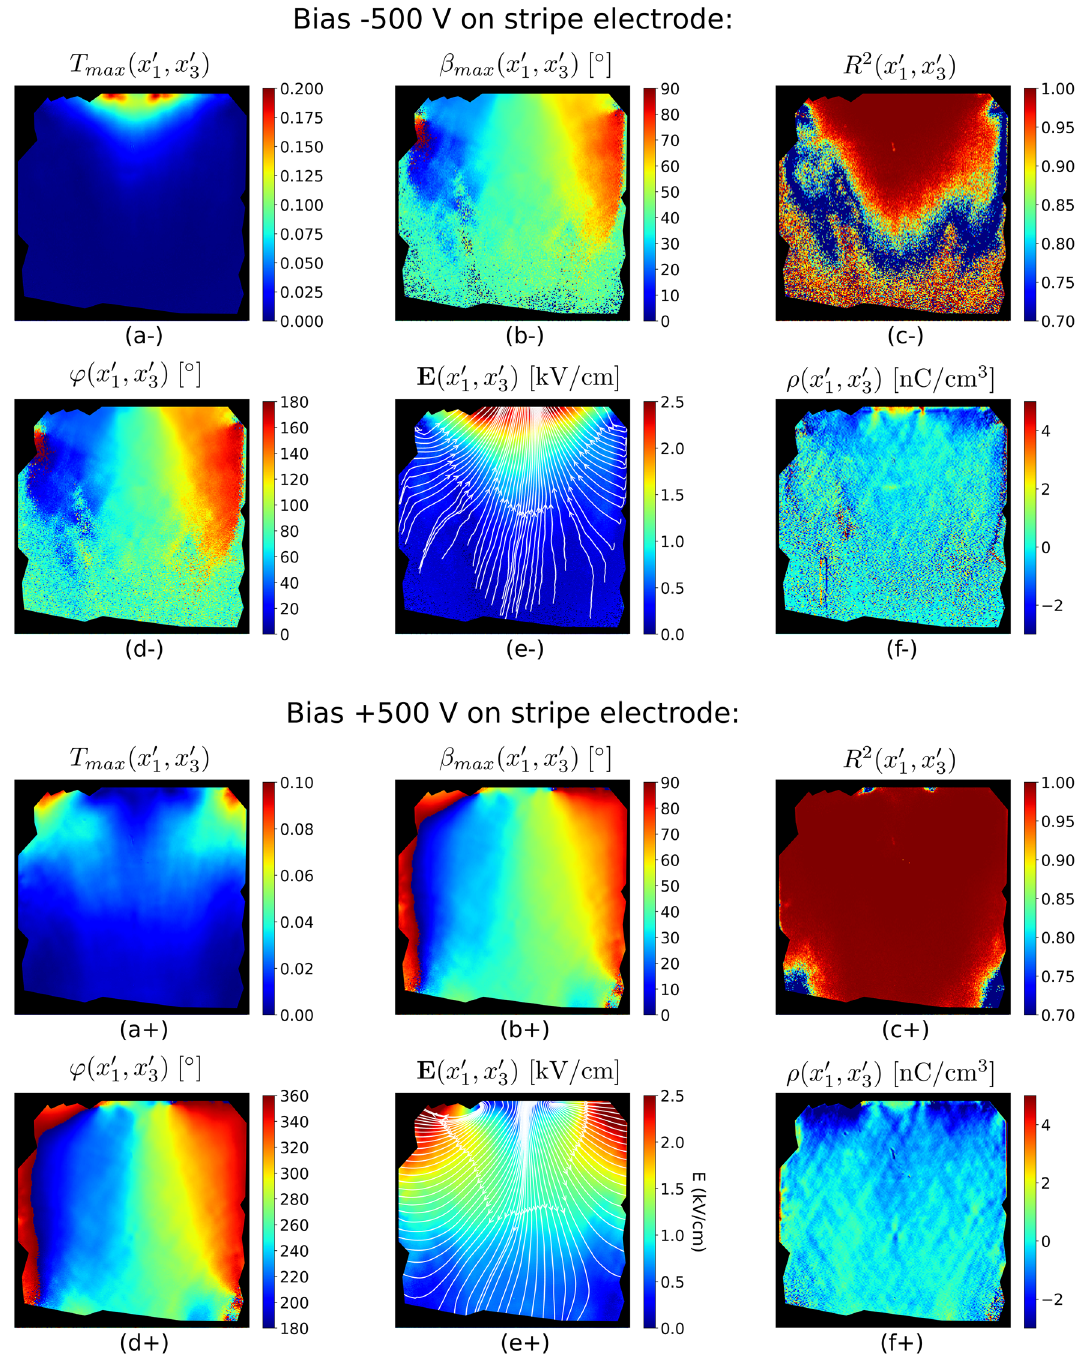
Figure 6. Electric field vector evaluation. Signs “ + ” and “−” indicate the polarity of the stripe electrode. x ′ 1 , x ′ 3 Distributions of the maxima of Pockels transmittance T max ( a ) and corresponding polarizer angle β max x ′ 1 , x ′ 3 ( b ) acquired by fitting the Pockels transmittance images using Eq. (18). Distribution of the (cid:31) (cid:30) x ′ 1 , x ′ 3 coefficient of determination R 2 of the fitting is shown in ( c ). Electric field directional angle ϕ distribution (cid:31) (cid:30) ( d ) was determined from β max based on the relation from Fig. 4. Electric field magnitude and direction (cid:31) (cid:30) x ′ 1 , x ′ 3 distribution are shown in ( e ). Space charge distribution ρ was calculated using Gauss law ( f ). Black areas denote the damaged parts along the edges of the (cid:30) (cid:31)